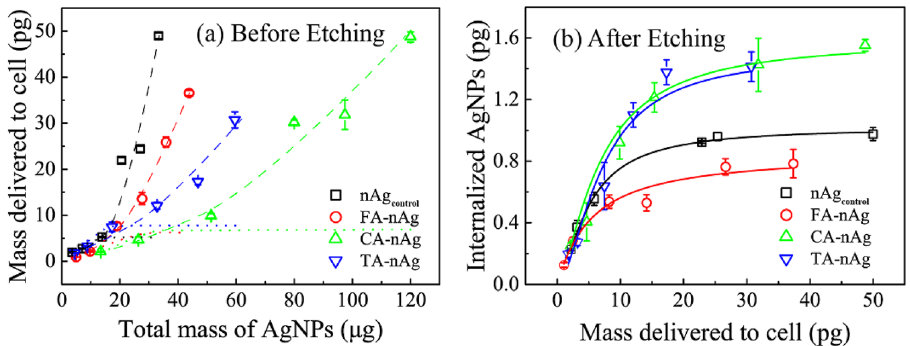
Figure 4. The internalization of AgNPs into A549 cell after exposure with different concentration of AgNPs suspension at 37 °C for 1 h. ( a ) Mass delivered to A549 cell ( M d , pg) against to the increase of given mass ( M T , μg) of nAg control , CA-nAg, FA-nAg and TA-nAg suspension. The dashed line was the trend line and the dotted line was the Langmuir rule line; ( b ) the mass of AgNPs internalized to A549 cell ( M i , pg) against to M d . The solid color lines were fitted based on logistics model.